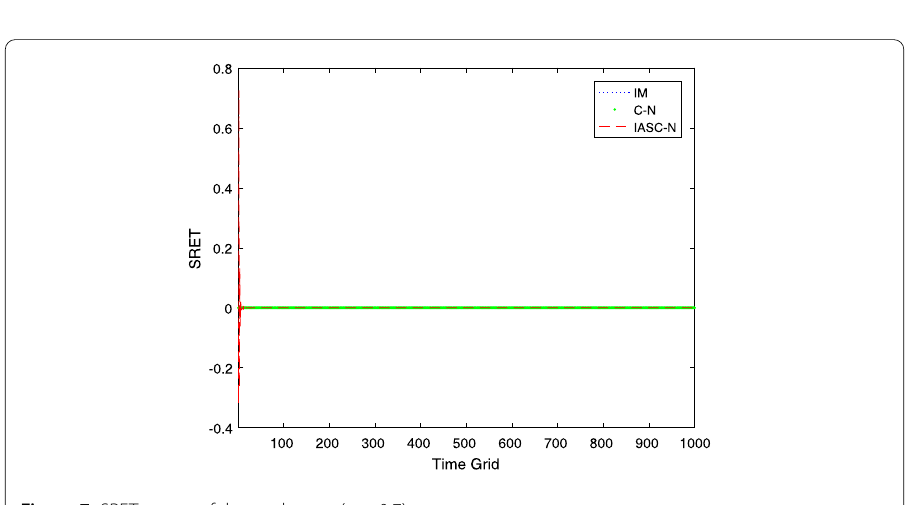
Figure 7 SRET curves of three schemes ( α =